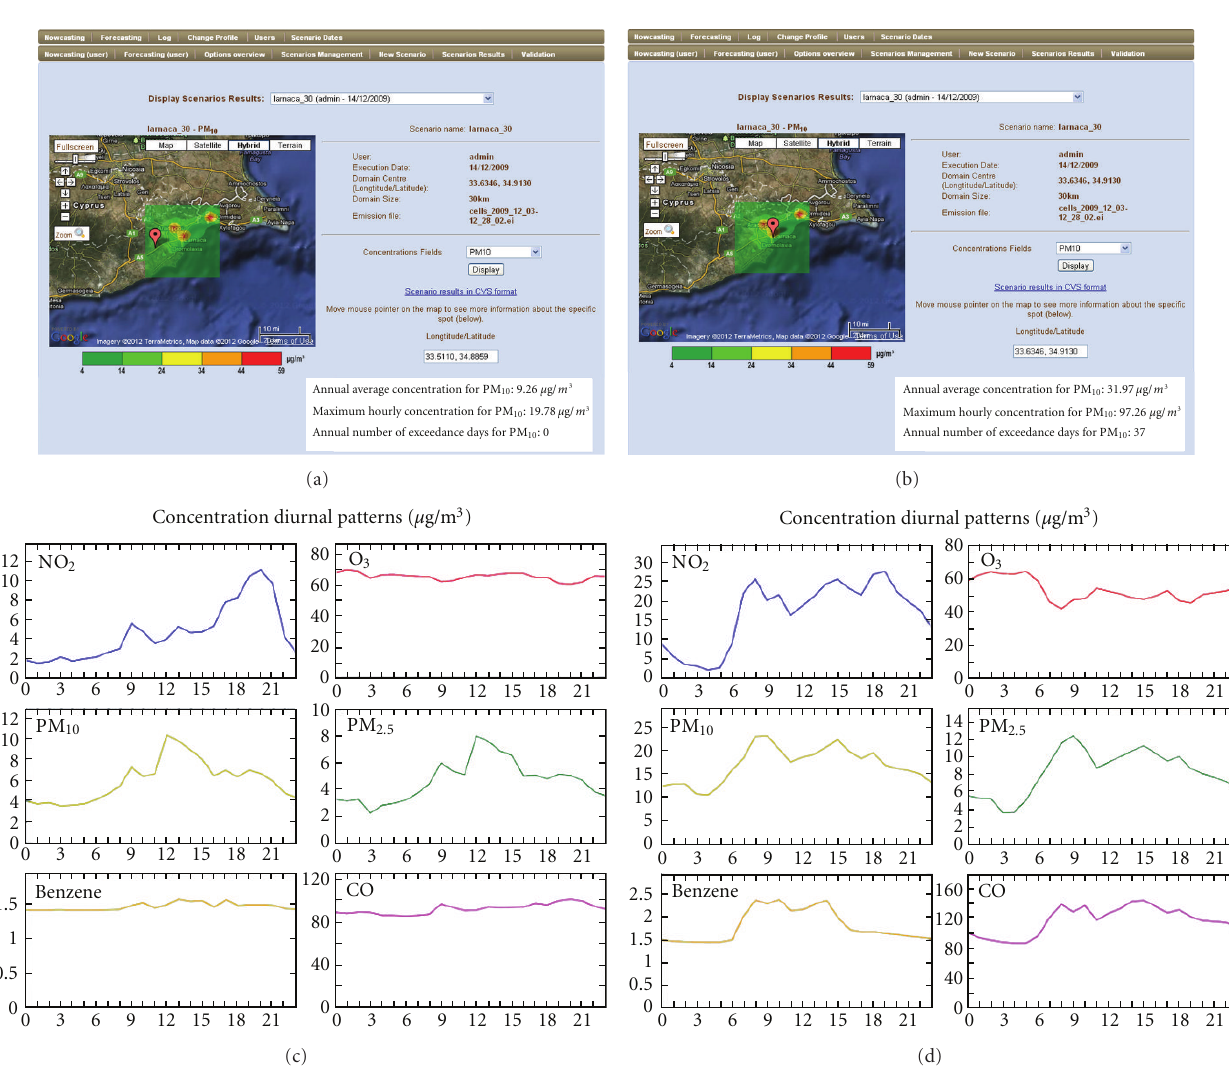
Figure 6: Statistical indices and graphs produced for two di ff erent locations inside the computational domain of a particular emission